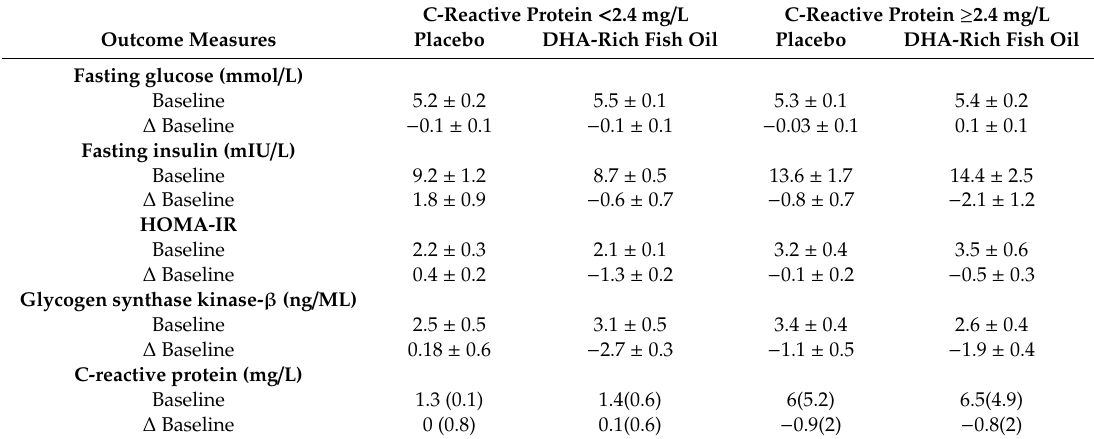
Table 3. Effects of DHA-rich fish oil on blood markers stratified by participants’ baseline inflammation status.